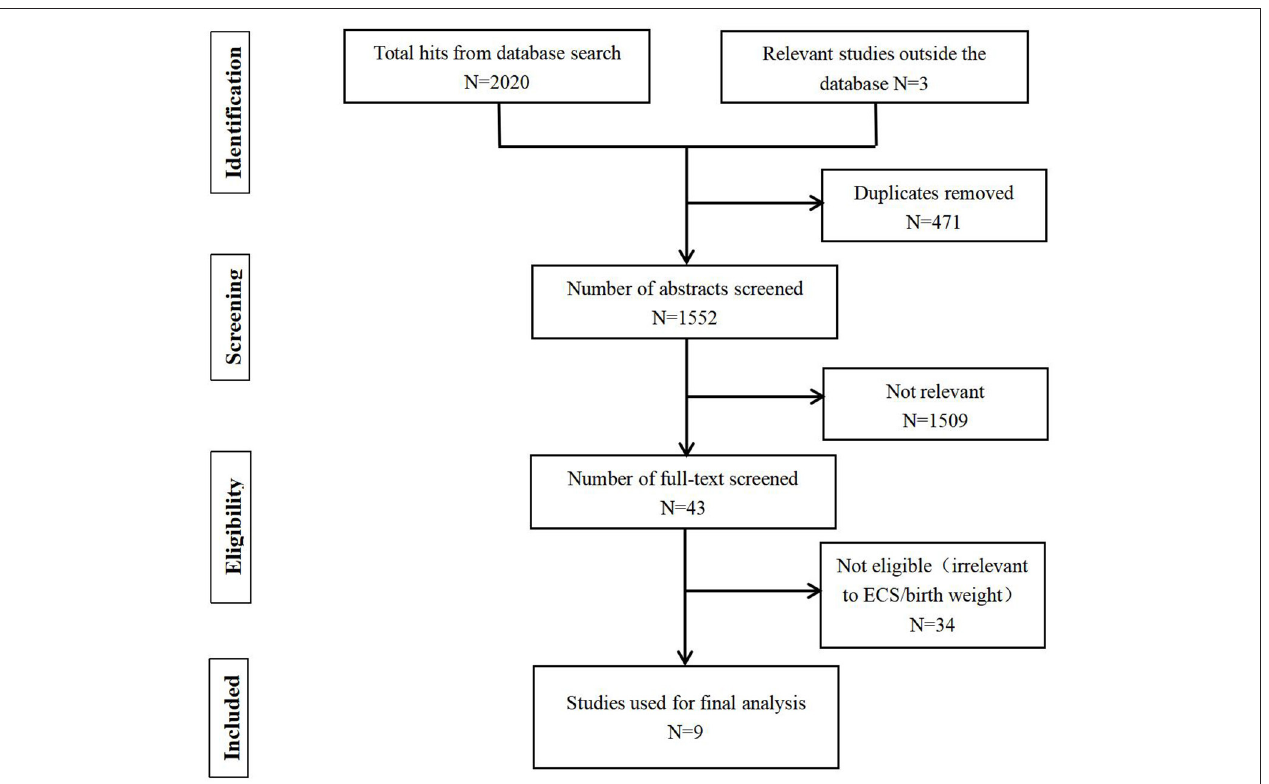
FIGURE 1 | Flowchart on literature search and study